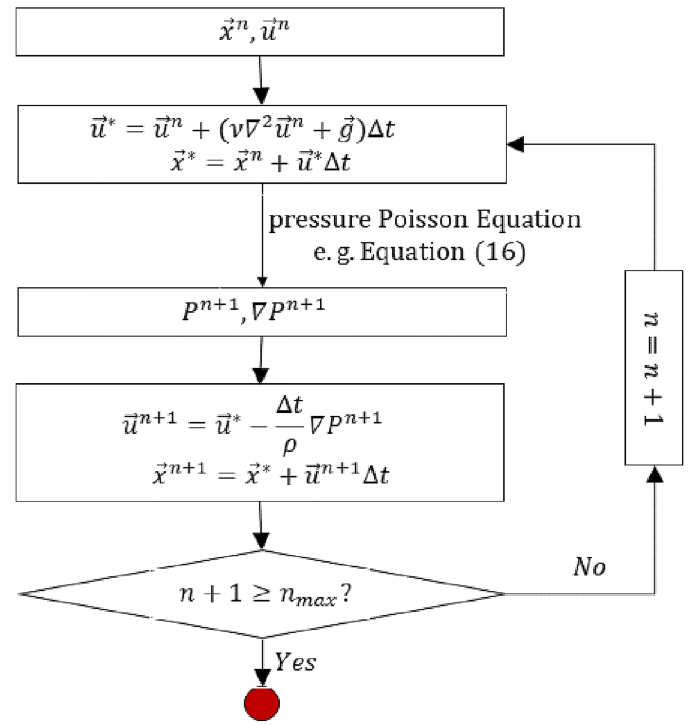
Figure 1. Simulation process of the original MPS scheme.